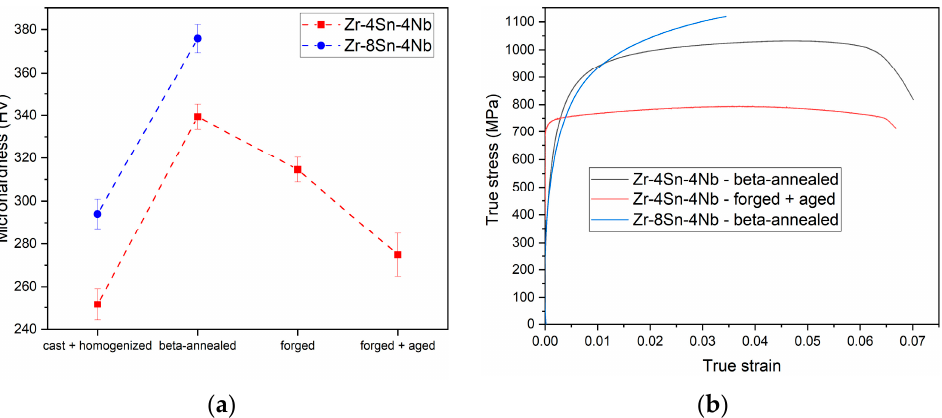
Figure 5. ( a ) The evolution of microhardness during alloys processing; ( b ) Tensile tests of beta- annealed Zr-4Sn-4Nb, Zr-8Sn-4Nb and forged + aged Zr-4Sn-4Nb alloy. Zr-8Sn-4Nb and forged + aged Zr-4Sn-4Nb